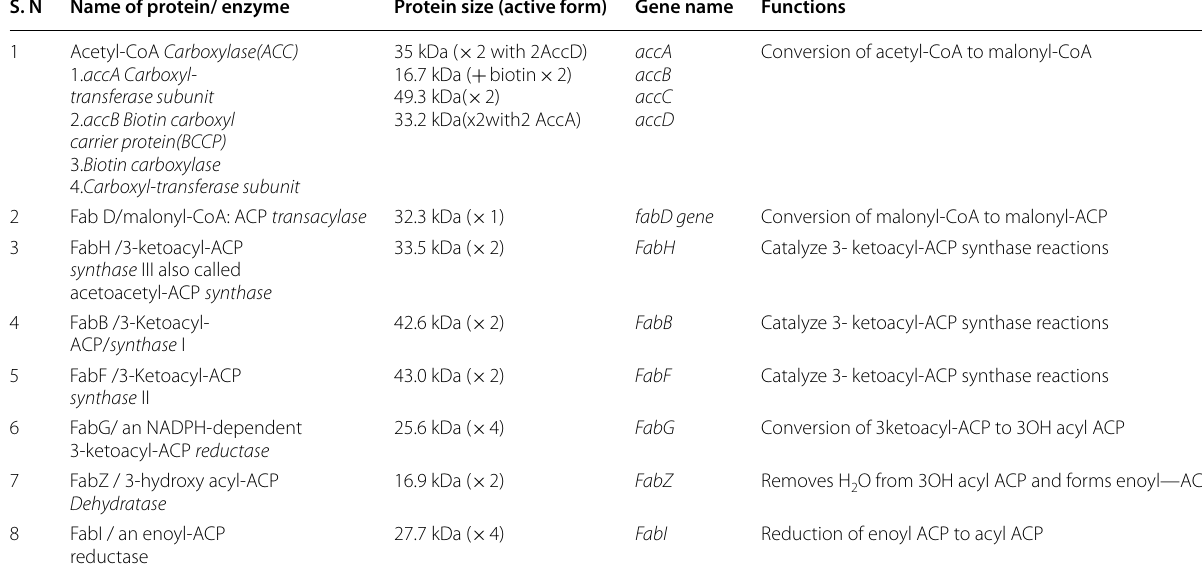
Table 2 Enzymes and genes envolve in lipid biosynthesis (Campbell and Cronan, 2010; Wang et al. 2021) S.